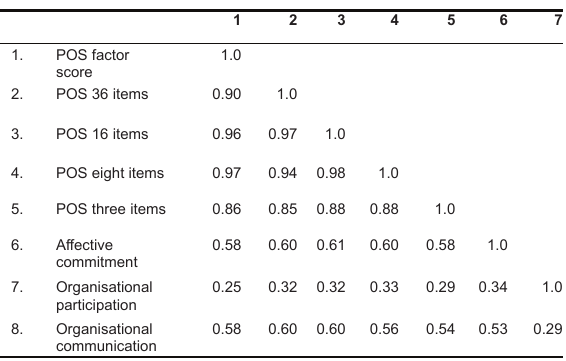
Table 2 Correlations between the POS factor score and POS total scores (N =